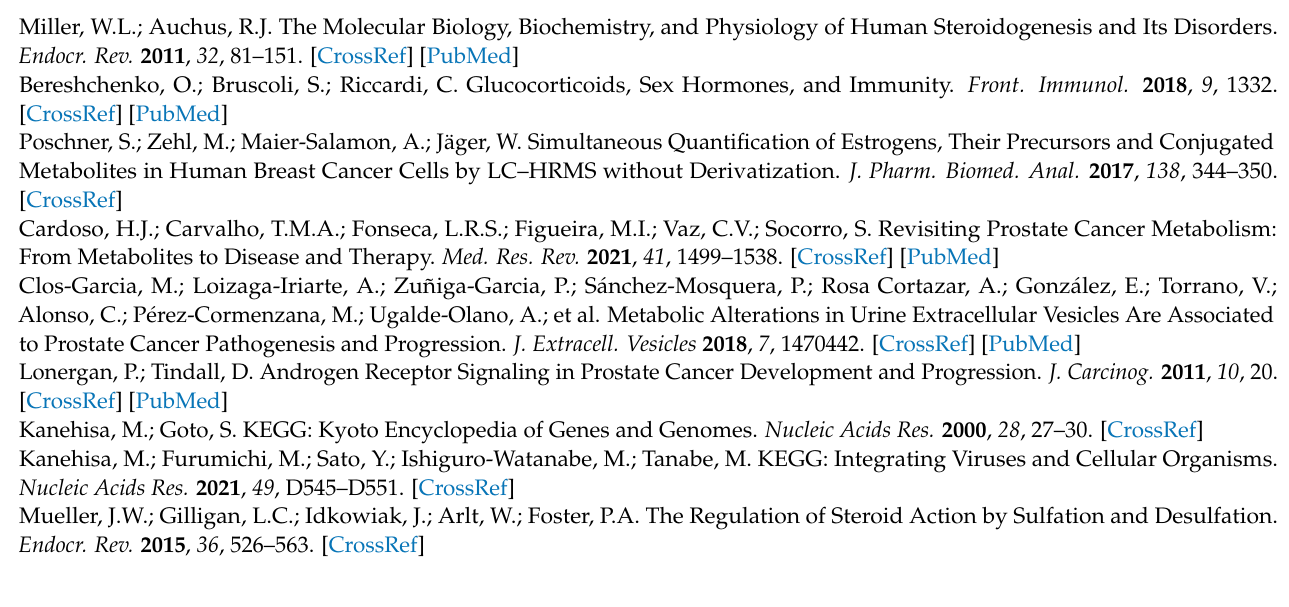
Table S1–S4 Supplementary tables with method optimization data and urine characterization; Sup- porting Information S3: Figure S1–S5 Supplementary figures including metabolomics network, method optimization results and urine